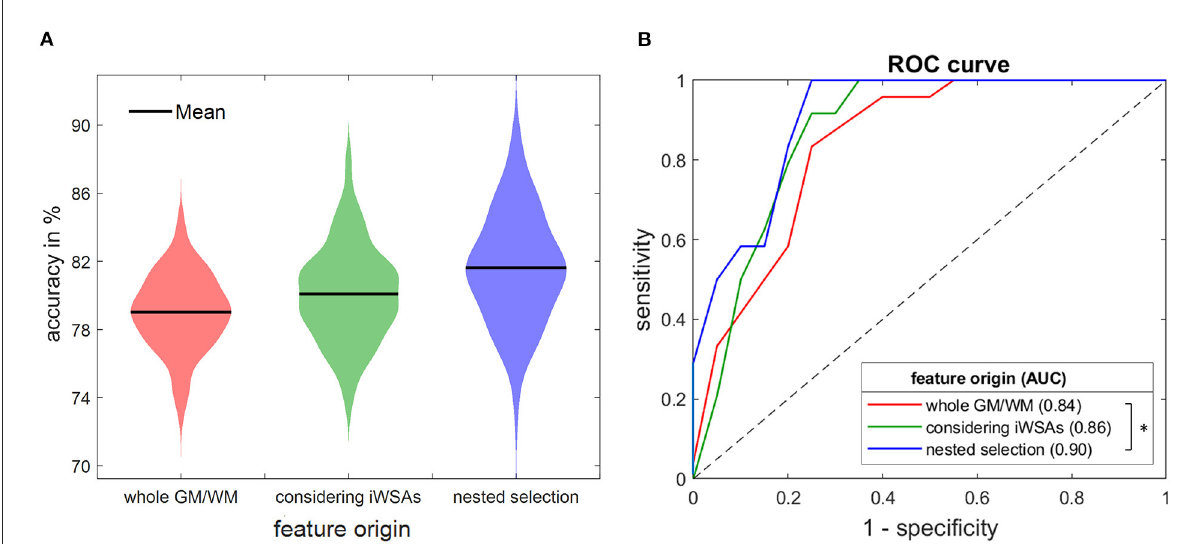
FIGURE4 Accuracies (A) and ROC curves (B) of three random forest models. The classifier was trained on features derived from whole GM/WM VOIs (red) and from inside and outside of iWSAs without using (green) and with using nested feature selection (blue), respectively. Depicted measures were averaged 100 times. (A) Violin plots show mean accuracies (black line). The width of the colored area represents the proportion of classifier iterations that reached the respective accuracy. Considering iWSAs yielded higher scores. Additional feature selection improved the accuracy further. (B) ROC curves of the three models. AUCs differed significantly comparing the model based on whole GM/WM VOIs to the one considering iWSAs with feature selection (Delong’s test, p < 0.05, asterisks). iWSA, individual watershed area; GM, gray matter; WM, white matter; ROC, receiver operating characteristics; AUC, area under the